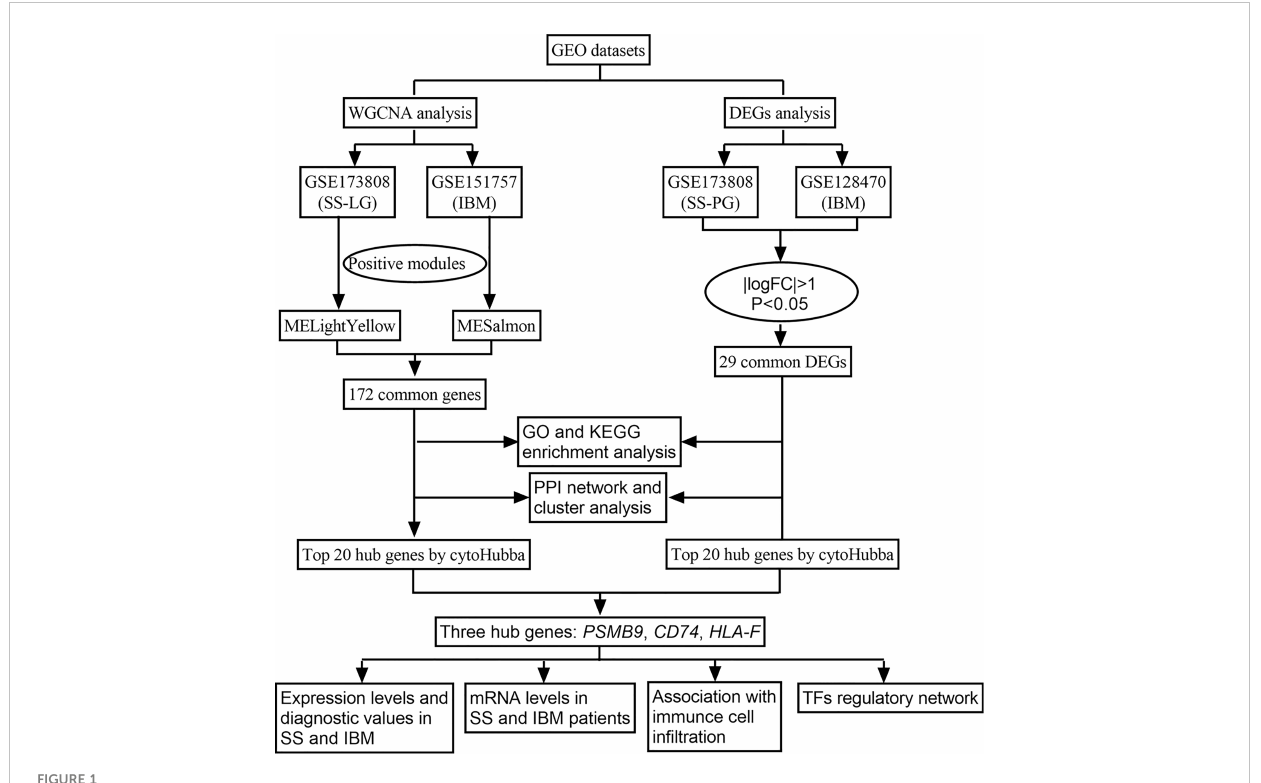
FIGURE 1 Flow chart of the